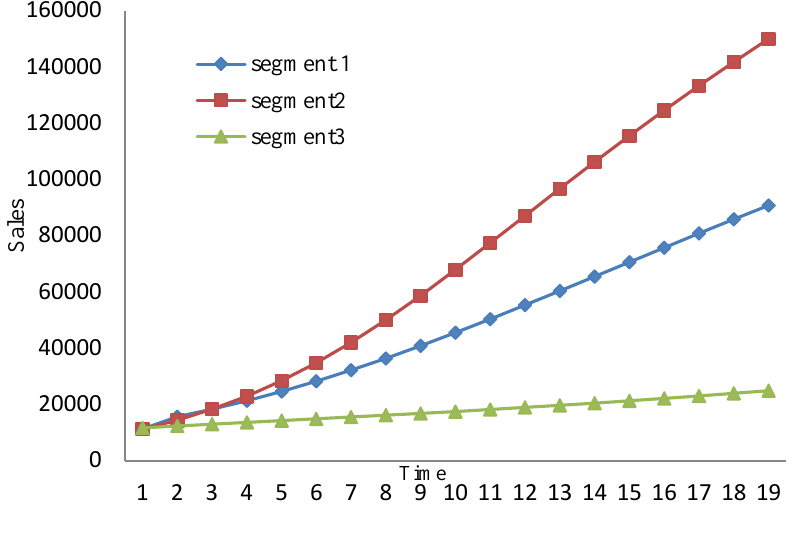
Figure 1. Optimal sales with dynamic market size